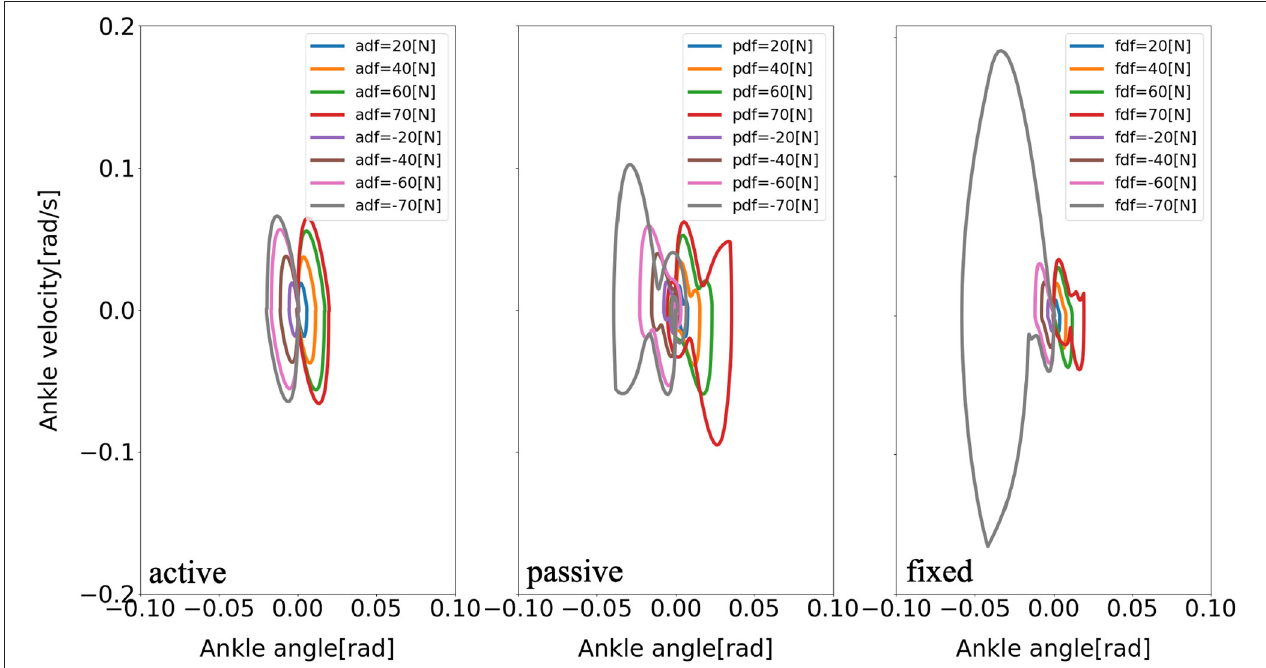
FIGURE 9 | Evolution of the ankle phase portrait of the model for three different arm states (active arm, passive arm, fixed arm) for different disturbing forces: (1) Push backward: − 20 [ N ], − 40 [ N ], − 60 [ N ], and − 70 [ N ]; (2) No force: 0 [ N ]; (3) Push forward: 20 [ N ], 40 [ N ], 60 [ N ], and 70 [ N ]. “a,” “p,” and “f” in the labels “adf,” “pdf,” and “fdf” represent the cases with active arms, passive arms, fixed arms, respectively, and “df” represents the disturbing forces.